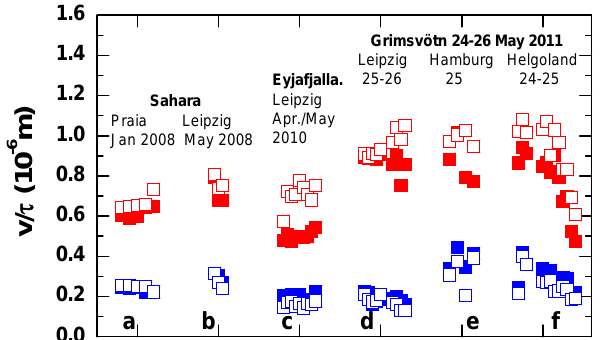
Fig. 1. Ratio v/τ of column volume concentration v to AOT τ at 532nm for coarse (red) and fine particles (blue). The ratios are de- rived from AERONET sun–sky photometer measurements in (a) mixed desert-dust/biomass–burning–smoke plumes at Praia, Cape Verde in January 2008, (b) during a strong Saharan dust outbreak at Leipzig in May 2008, (c) during the Eyjafjallaj¨okull event (Leipzig, April–May 2010), and (d–f) the Grimsv¨otn volcanic dust episode (Helgoland, Hamburg, Leipzig, May 2011). Fine-mode and coarse- mode τ values were calculated by using the Dubovik approach (open symbols) and the O’Neill method (closed symbols). See text for more